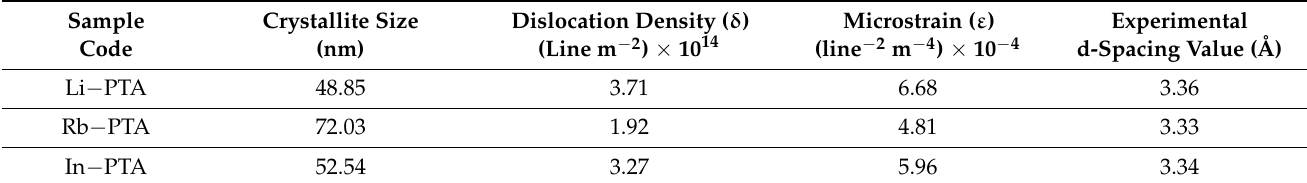
Table 2. Structural parameters of Li − PTA, Rb − PTA, and In − PTA thin